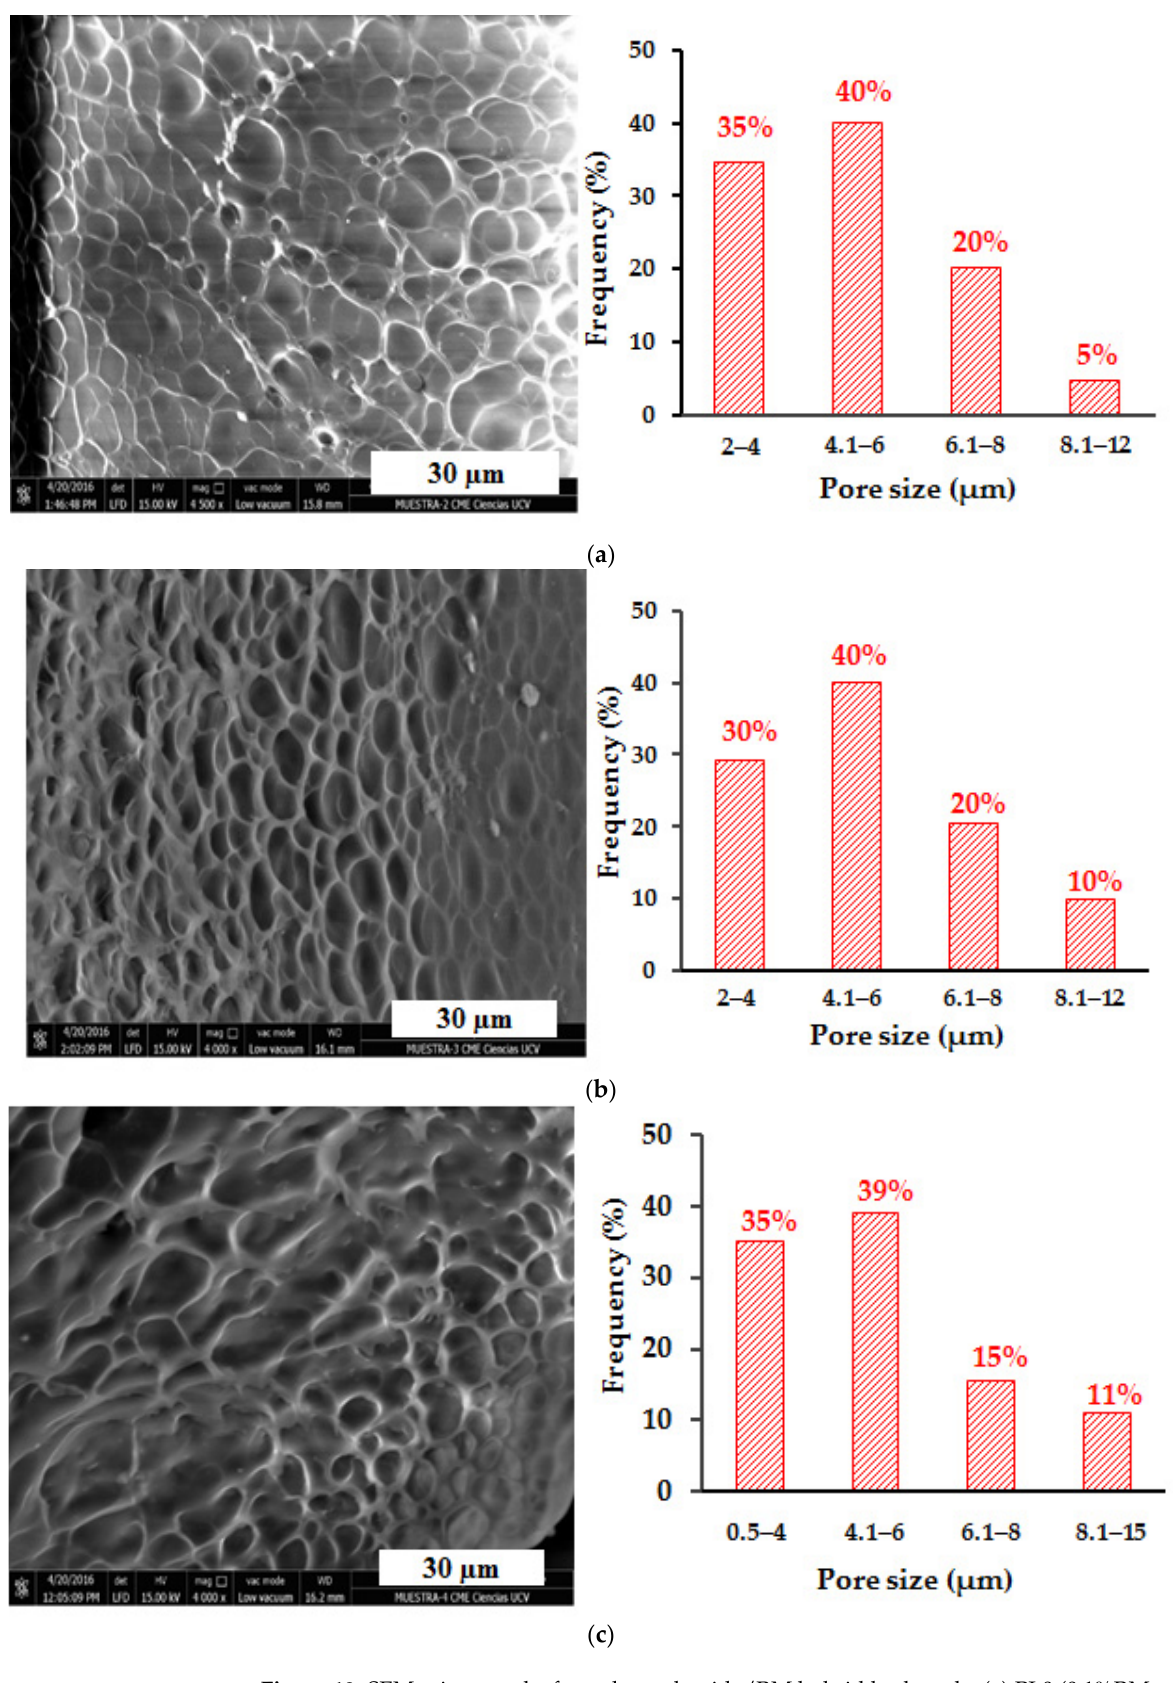
Figure 18. SEM micrographs for polyacrylamide/RM hybrid hydrogels: ( a ) PL0 (0.1%RM, n =